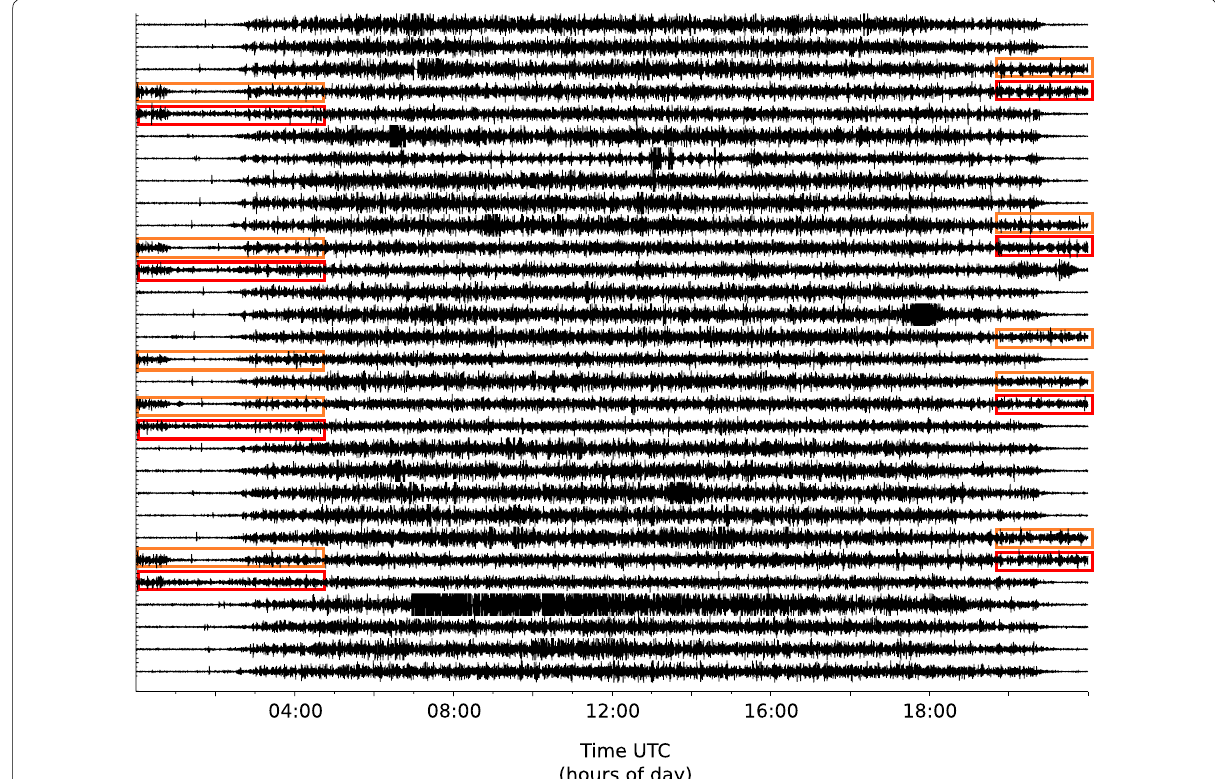
Fig. 7 Low-frequency recording of the subway activity at the ICJA broad-band seismometer. Displayed data correspond to the vertical component of the seismic acceleration, bandpass filtered between 0.08 and 0.05 Hz. Each line shows 1 day, between September 27 and October 26, 2017. The different timetable of the subway system during the Friday and Saturday nights (orange and red boxes) is clearly shown by the seismic data. The night between the 11 and 12th October shows the same pattern than Fridays, as October 12th is a bank holiday in